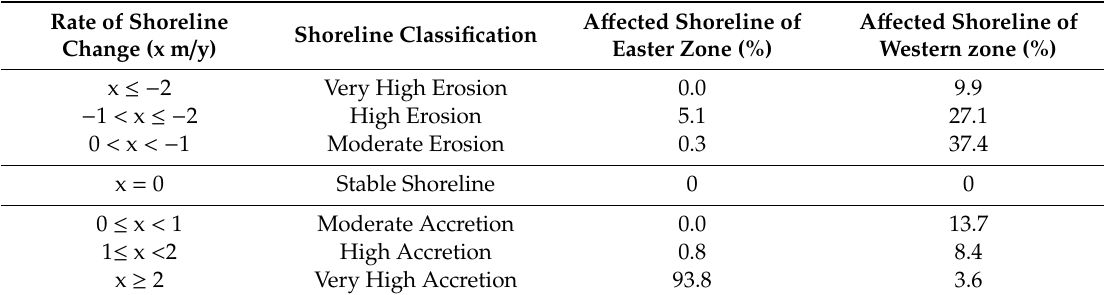
Table 3. Shoreline classification based on EPR [39].